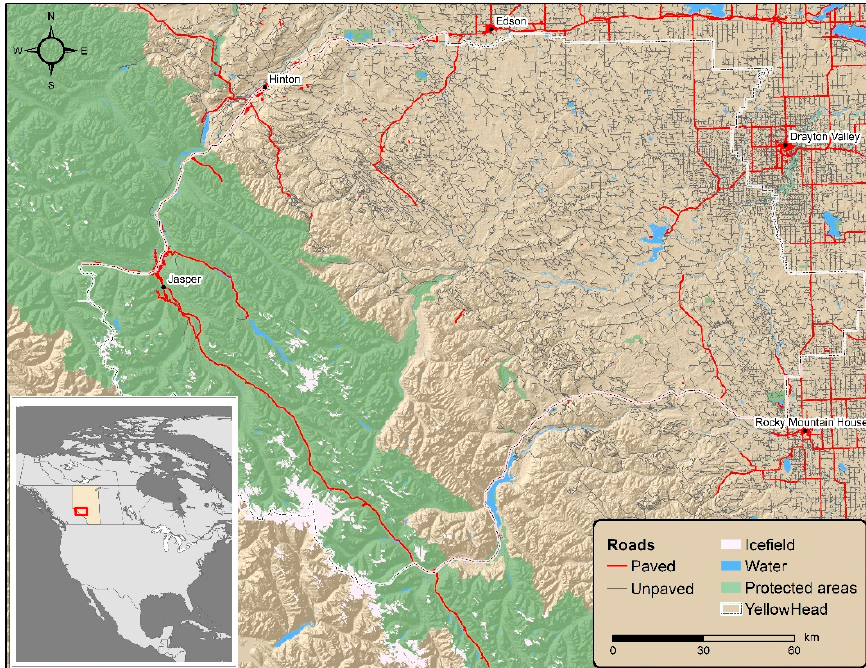
Figure 1. Map of the road network within the study area in western Alberta, Canada.